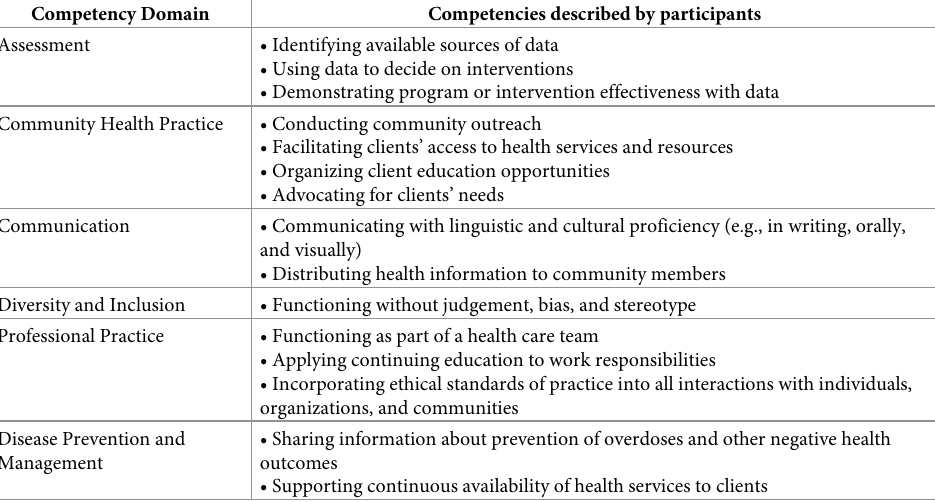
Table 1. Competency domains and competencies from Covert et al. (2019) framework showcased by